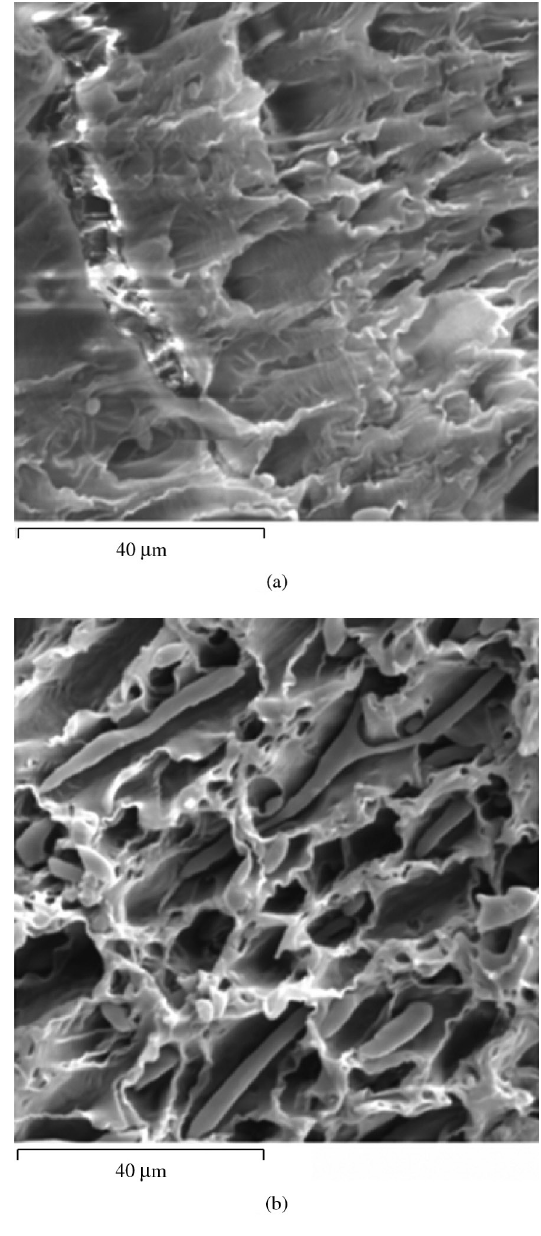
Figure 5. SEM micrographs of fractured surfaces of (a) 90/10 LDPE/PHB blend (b) 80/20 LDPE/PHB